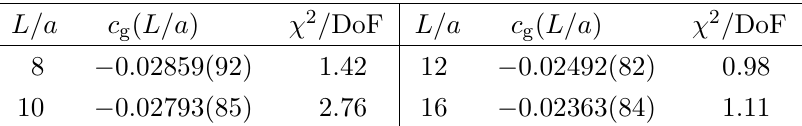
Table 9 . The (cid:12)t results for c g at each lattice.